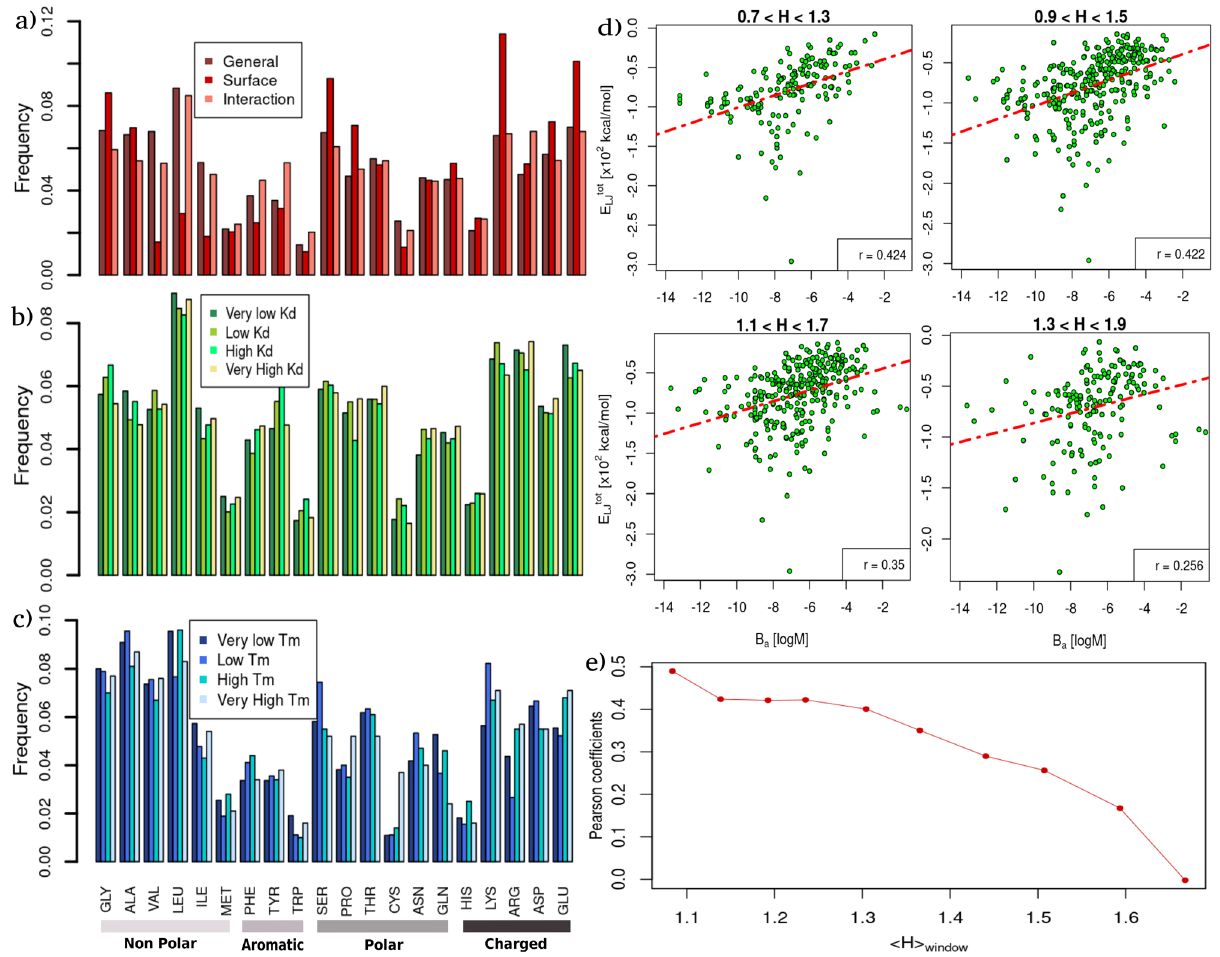
Figure 3. Comparing amino acid composition and hydropathy properties in proteins with different thermal stability and binding affinity. ( a ) Relative abundances of each of the twenty natural amino acids in the T m and B a datasets (see “Methods” section for details). For each kind of amino acid, the red bar corresponds to the abundance found in the solvent-exposed residues; the pink one refers to the residues found in interaction with the molecular partner, and dark red bars are computed considering all residues. ( b ) Relative abundances of each of the twenty natural amino acids found in the binding site regions of the B a dataset stratified by four groups of different binding affinities. Bar colors range from green to yellow as the B a of the considered complexes increases. ( c ) Relative abundances of each of the twenty natural amino acids found in the T m dataset,